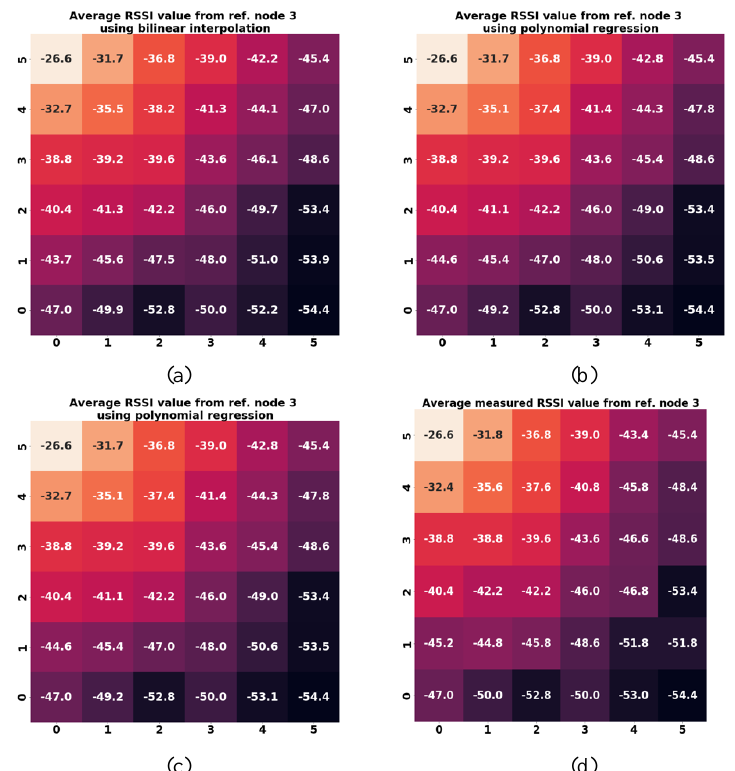
Figure 20. RSSI heatmap reference node 3. a) Bilinear inter., b) Polynomial reg., c) Polynomial inter., d) Measurement